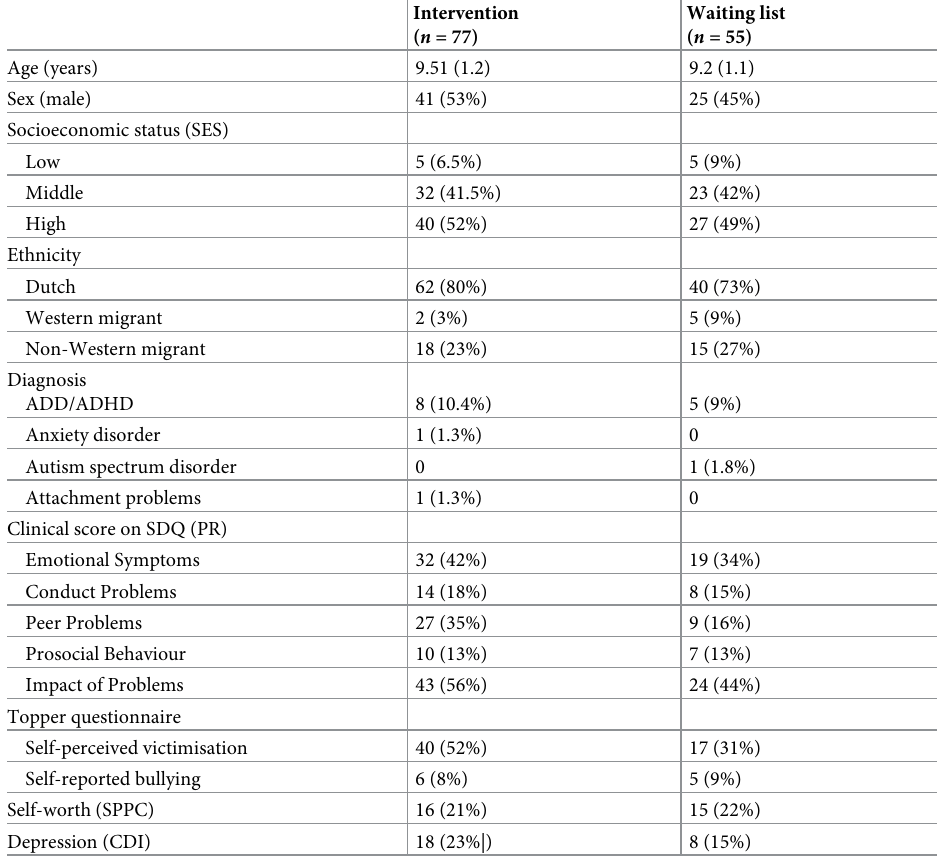
Table 1. Baseline demographic and clinical characteristics of intervention and waiting list group.